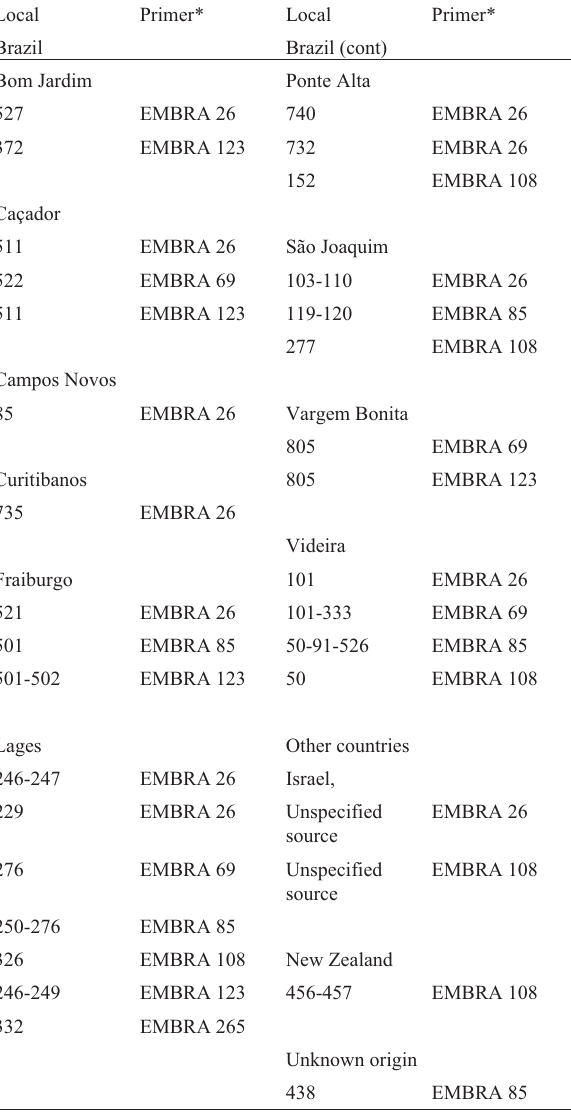
Table 3 - Origin of the plant accessions presenting alleles with a low fre- quency (f < 0.05). All Brazilian cities are located in the state of Santa